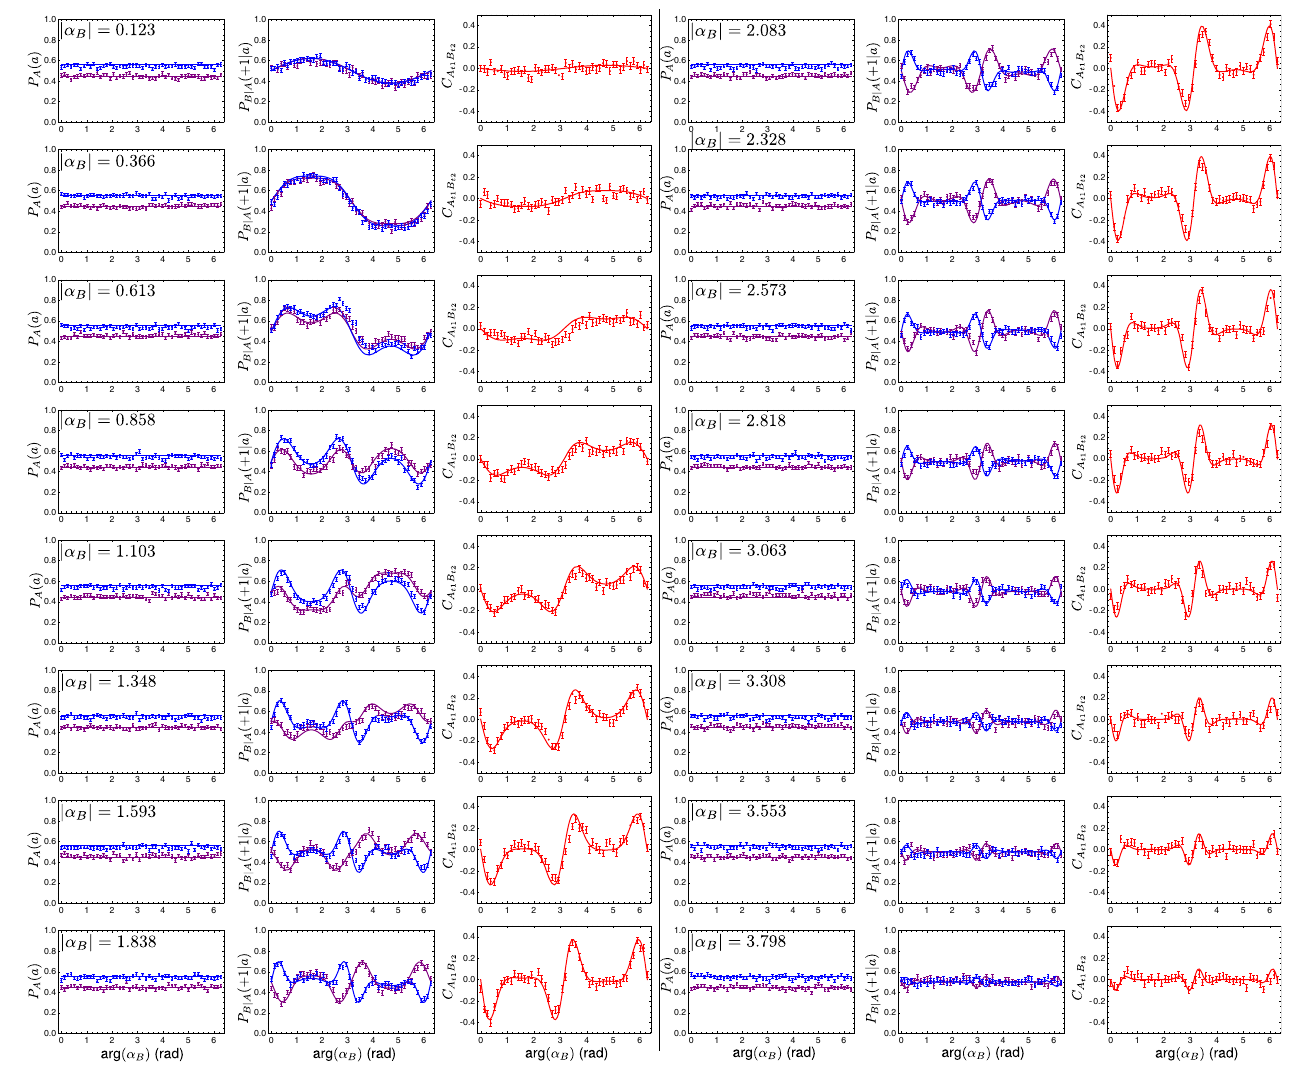
FIG. 8. Two-time correlation measurement in the asymmetric implementation. The fixed experimental settings were α A ¼ 2 . 1 , ϕ 0 , ϕ π = 2 . The blue points show a ¼ þ 1 measurement results, while purple points shows a ¼ − 1 . Solid lines show the A ¼ B ¼ expectations for an ideal experiment. Error bars of P A ð a Þ ; P B ðþ 1 j a Þ are given as SEM, from these the error bars of C AB are j A propagated. The data sets shown here together create the false-color plot of Fig. 4(a) in the main (an example of such a noise source would be noise due to the main lines measured by a line-triggered experiment). For such ˆ Q a periodic noise source, we find h i ¼ h P ðþ 1 Þ − P ð − 1 Þi ¼